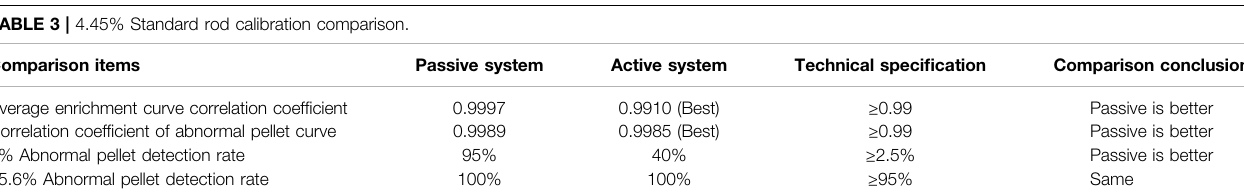
TABLE 3 | 4.45% Standard rod calibration comparison. Comparison items